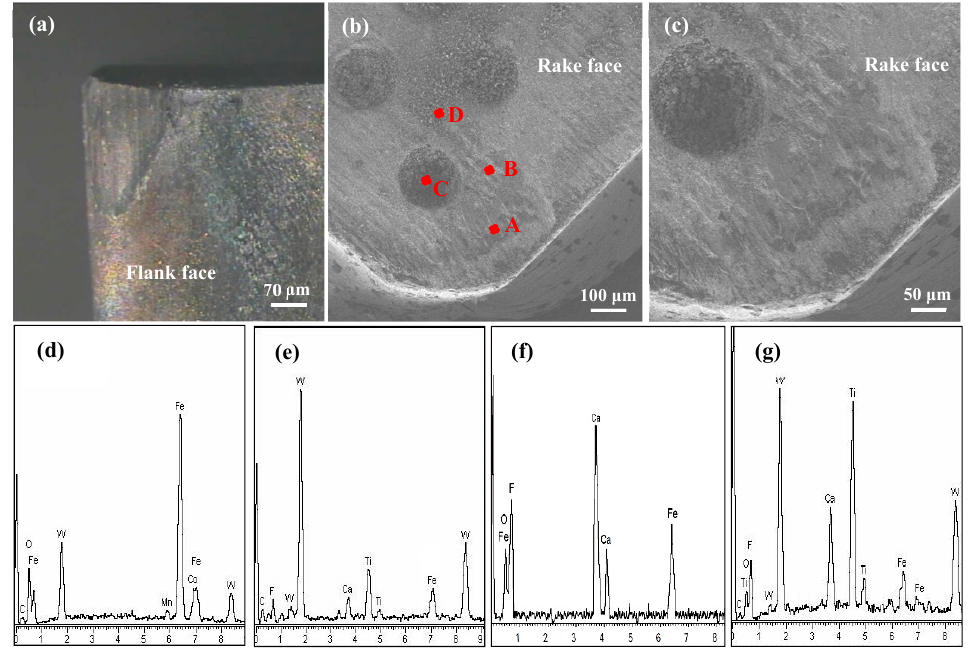
Figure 15. SEM micrographs and EDX component analysis of SCT1surfac after 5 min dry cutting at speed of 100 m/min: ( a ) Micrograph of worn flank face; ( b ) SEM micrograph of worn rake face, ( c ) enlarge micrograph corresponding to ( b , d – g ) corresponding EDX component analysis of point A, B, C and D in ( b ).